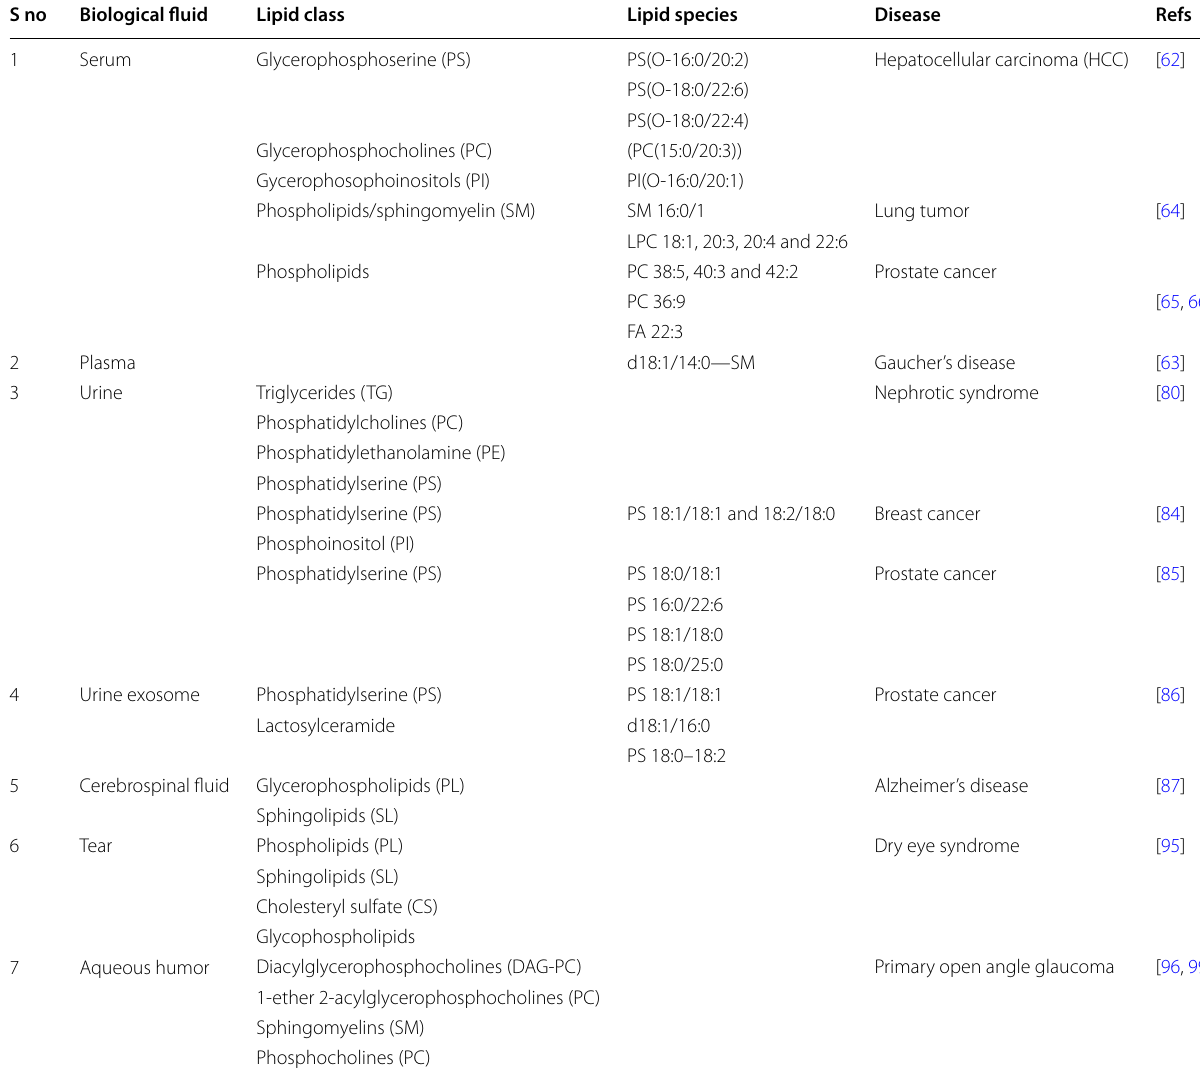
Table 1 List of lipids identified as probable diagnostic markers in biological